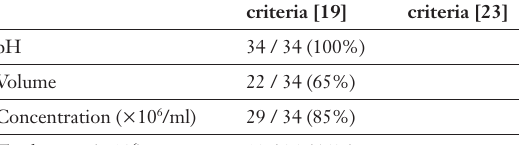
Number/Percentage of fertile Swiss men who reach normal criteria (n =